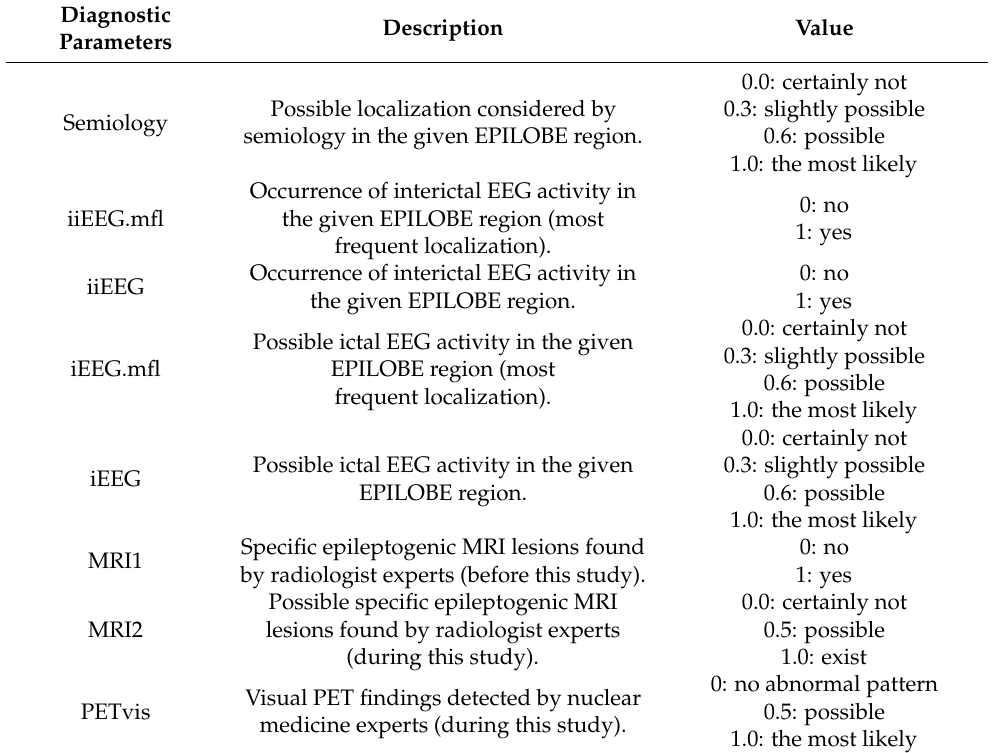
Table 3. EPILOBE region-wide electroclinical and expert-based imaging data recorded during the